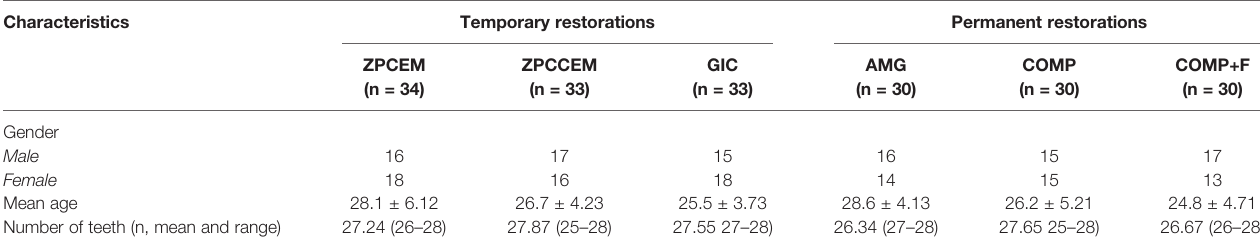
TABLE 1 | Characteristics of the study